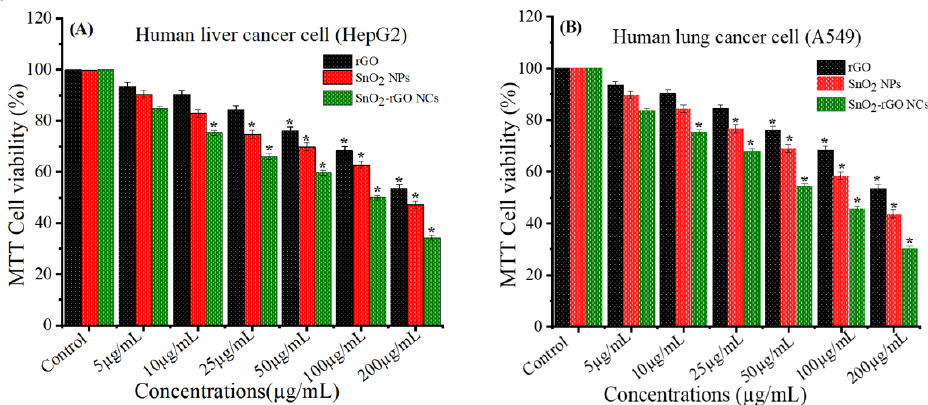
Figure 13. Cytotoxicity of rGO, SnO 2 NPs, and SnO 2 -rGO NCs in human liver cancer HepG2 cells ( A ) and lung cancer A549 cells ( B ); one-way ANOVA followed by the post hoc test was applied for statistical analysis. * p < 0.05, statistically significant difference when compared to the control group. Table 3. IC 50 values of SnO 2 NPs and SnO 2 -rGO NCs for two types of human cancer cells. Samples